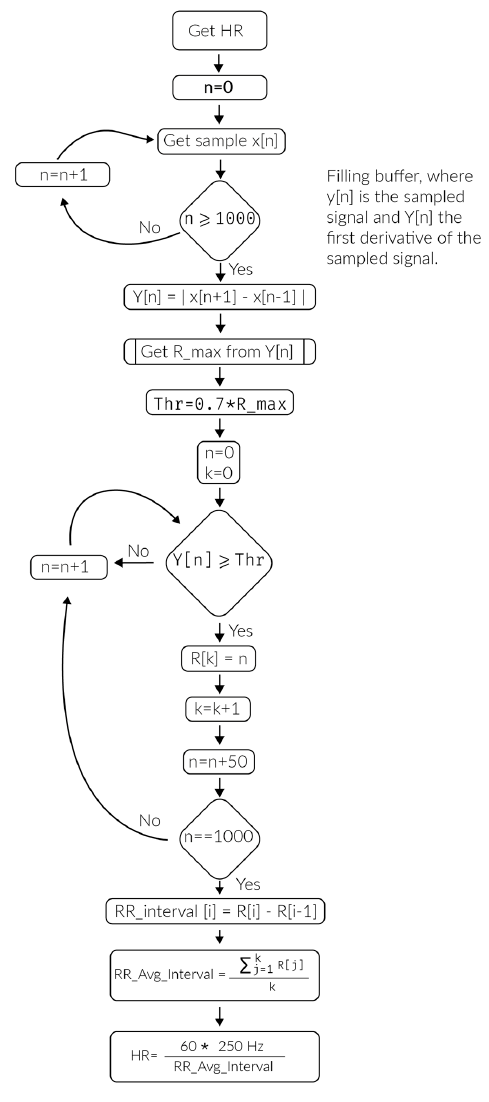
Figure 12. Heart rate detection algorithm.